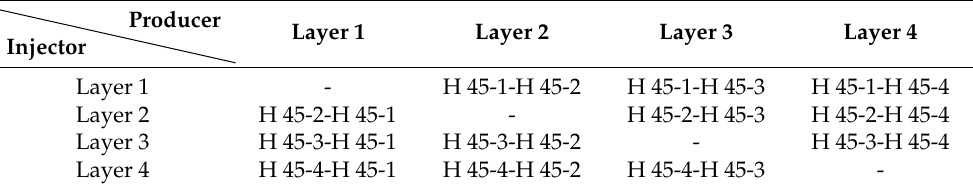
Table 8. Well pattern descriptions of the H45-H45 group.